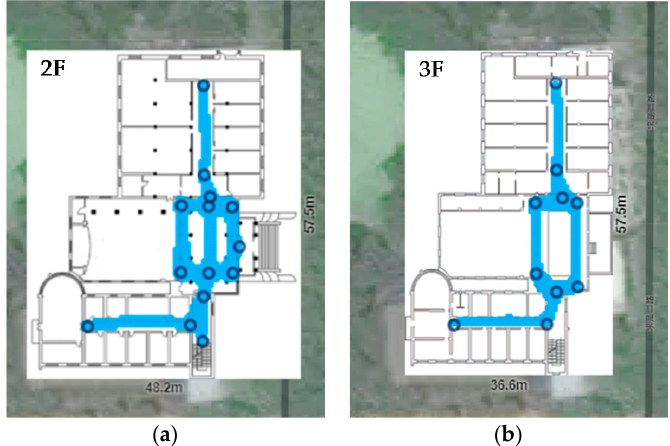
Figure 15. Coverage of site survey on IndoorAtlas. ( a , b ) are survey maps on the second floor and third floors, respectively. The black circles are waypoints we added in this experiment. A waypoint is pinpointed places on a map, and need to be check-in to define the actual position in data recording process.